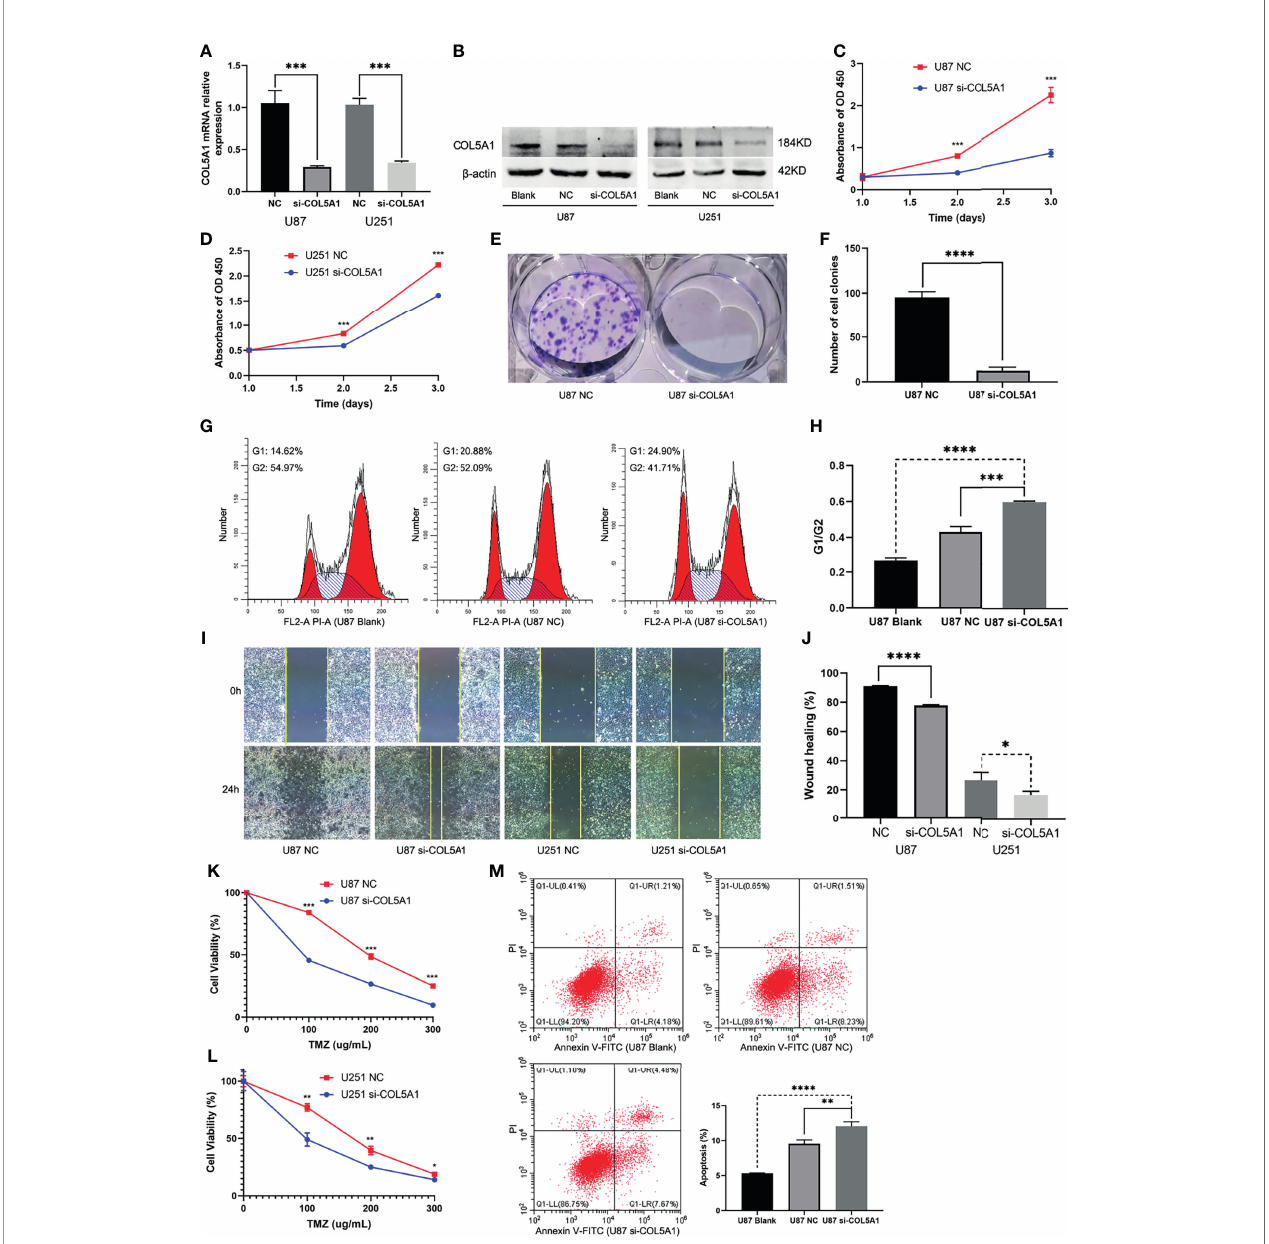
FIGURE 4 | Knockdown of COL5A1 inhibits proliferation, migration, and TMZ resistance of glioma cells in vitro . (A, B) The relative expressions of COL5A1 in U251 and U87 cells were analyzed by qRT-PCR and Western blot after transfected with si-COL5A1. (C, D) The proliferation ability was determined using the CCK-8 assay following 3 days of culture. (E, F) The long-term cell viability was evaluated using the colony formation assay. (G, H) The cell-cycle phase of U87 cells was analyzed by fl ow cytometry. (I, J) Wound healing assay was performed to explore the cell ’ s migration ability. (K, L) Knockdown of COL5A1 could sensitize glioma cells to temozolomide. (M) Knockdown of COL5A1-sensitized tumor to TMZ chemotherapy by promoting apoptosis (*p < 0.05; **p < 0.01; ***p < 0.001, ****p <